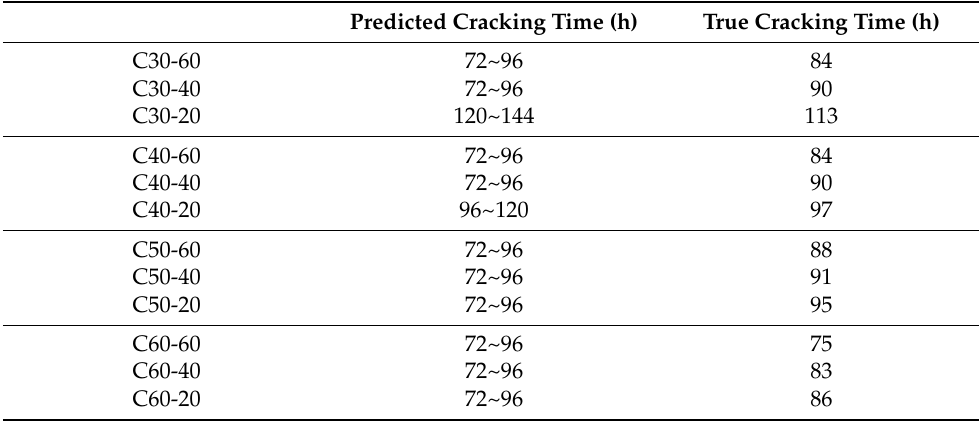
Figure 10. Concrete cracking time schematic diagram: ( a ) C30; ( b ) C40; ( c ) C50; ( d ) C60. Table 10. Cracking prediction.